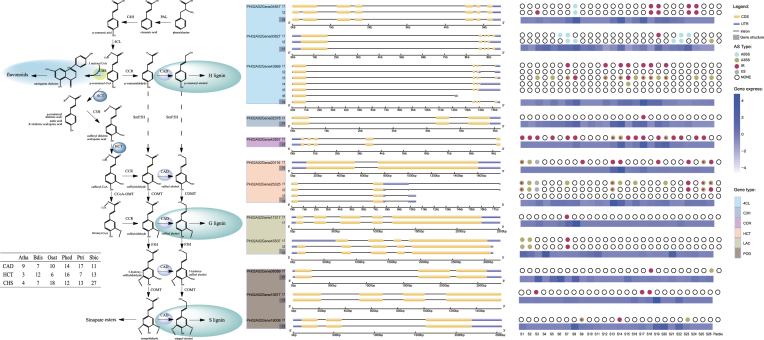
The gene family expansion and AS abundance of bamboo in the lignin biosynthetic pathway. (A) A total of 13 gene families in the lignin biosynthetic pathway were identified using six genomes, i.e., A. thaliana, B. distachyon, O. sativa, Ph. edulis, P. trichocarpa, and S. bicolor. The copy number and genes under positive selection were added. (B) The structure, distribution, and types of AS and related gene expression levels for the six gene families (4CL, C3H, CCR, HCT, LAC, and POD). The lignin biosynthetic enzymes are PAL, phenylalanine ammonia-lyase; TAL, tyrosine ammonia-lyase; C4H, cinnamate 4-hydroxylase; C3H, 4-hydroxycinnamate 3-hydroxylase; COMT, caffeic acid 3-O-methyltransferase; F5H, ferulate 5-hydroxylase; 4CL, 4-coumarate:CoA ligase; CCoA-3H, coumaroyl-coenzyme A 3-hydroxylase; CCoA-OMT, caffeoyl-coenzyme A O-methyltransferase; CCR, cinnamoyl-CoA reductase; CAD, cinnamyl alcohol; and HCT, dehydrogenase hydroxycinnamoyl transferase.